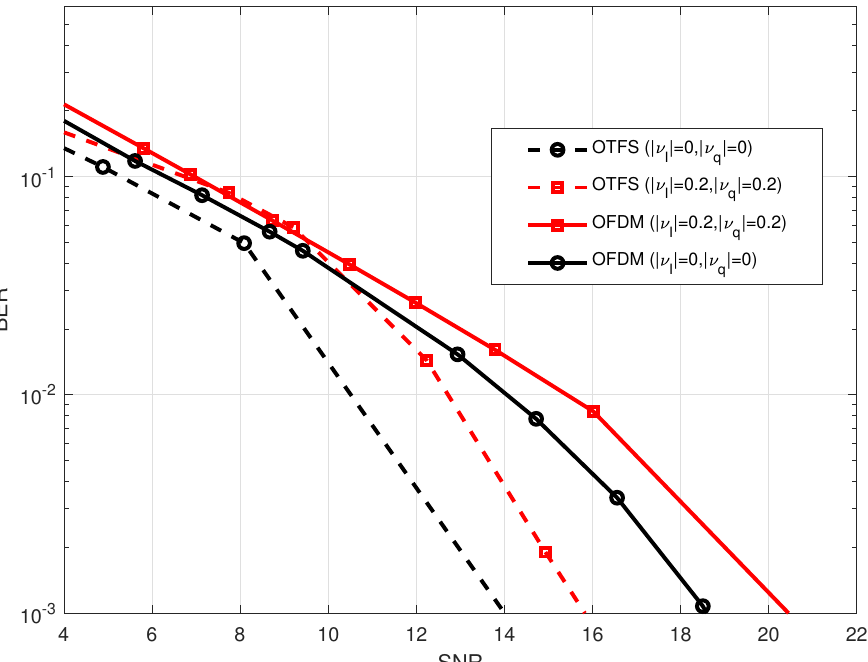
Figure 11. Comparison of the BER performance between OTFS waveform with M = 32, N = 32 and OFDM waveform with N = 1024 considering different DC-offest in both I-component ( γ I ) and Q-component ( γ Q ) at 2.4 GHz carrier